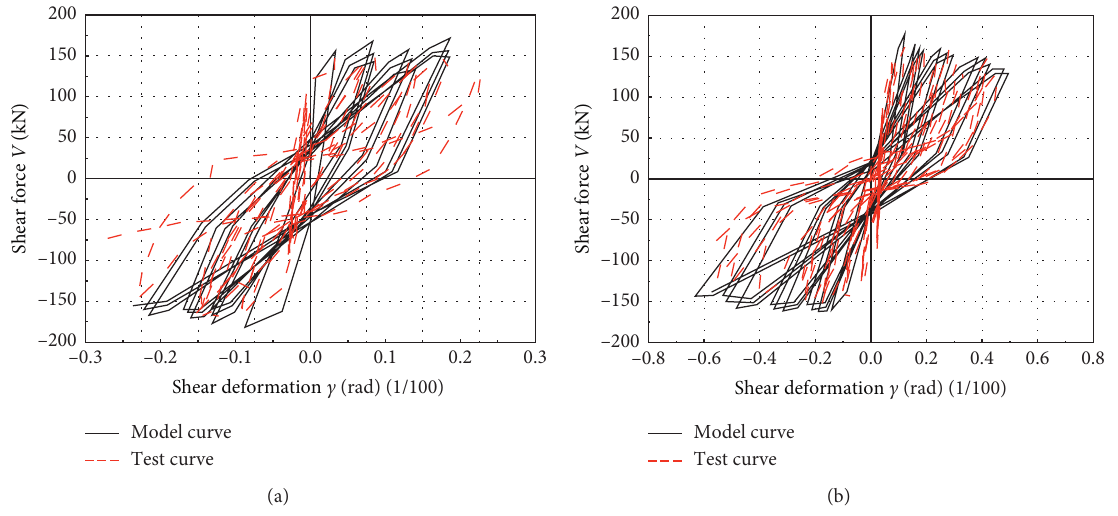
Figure 13: Comparison of calculated and test result. (a) 0.3-Se. (b)